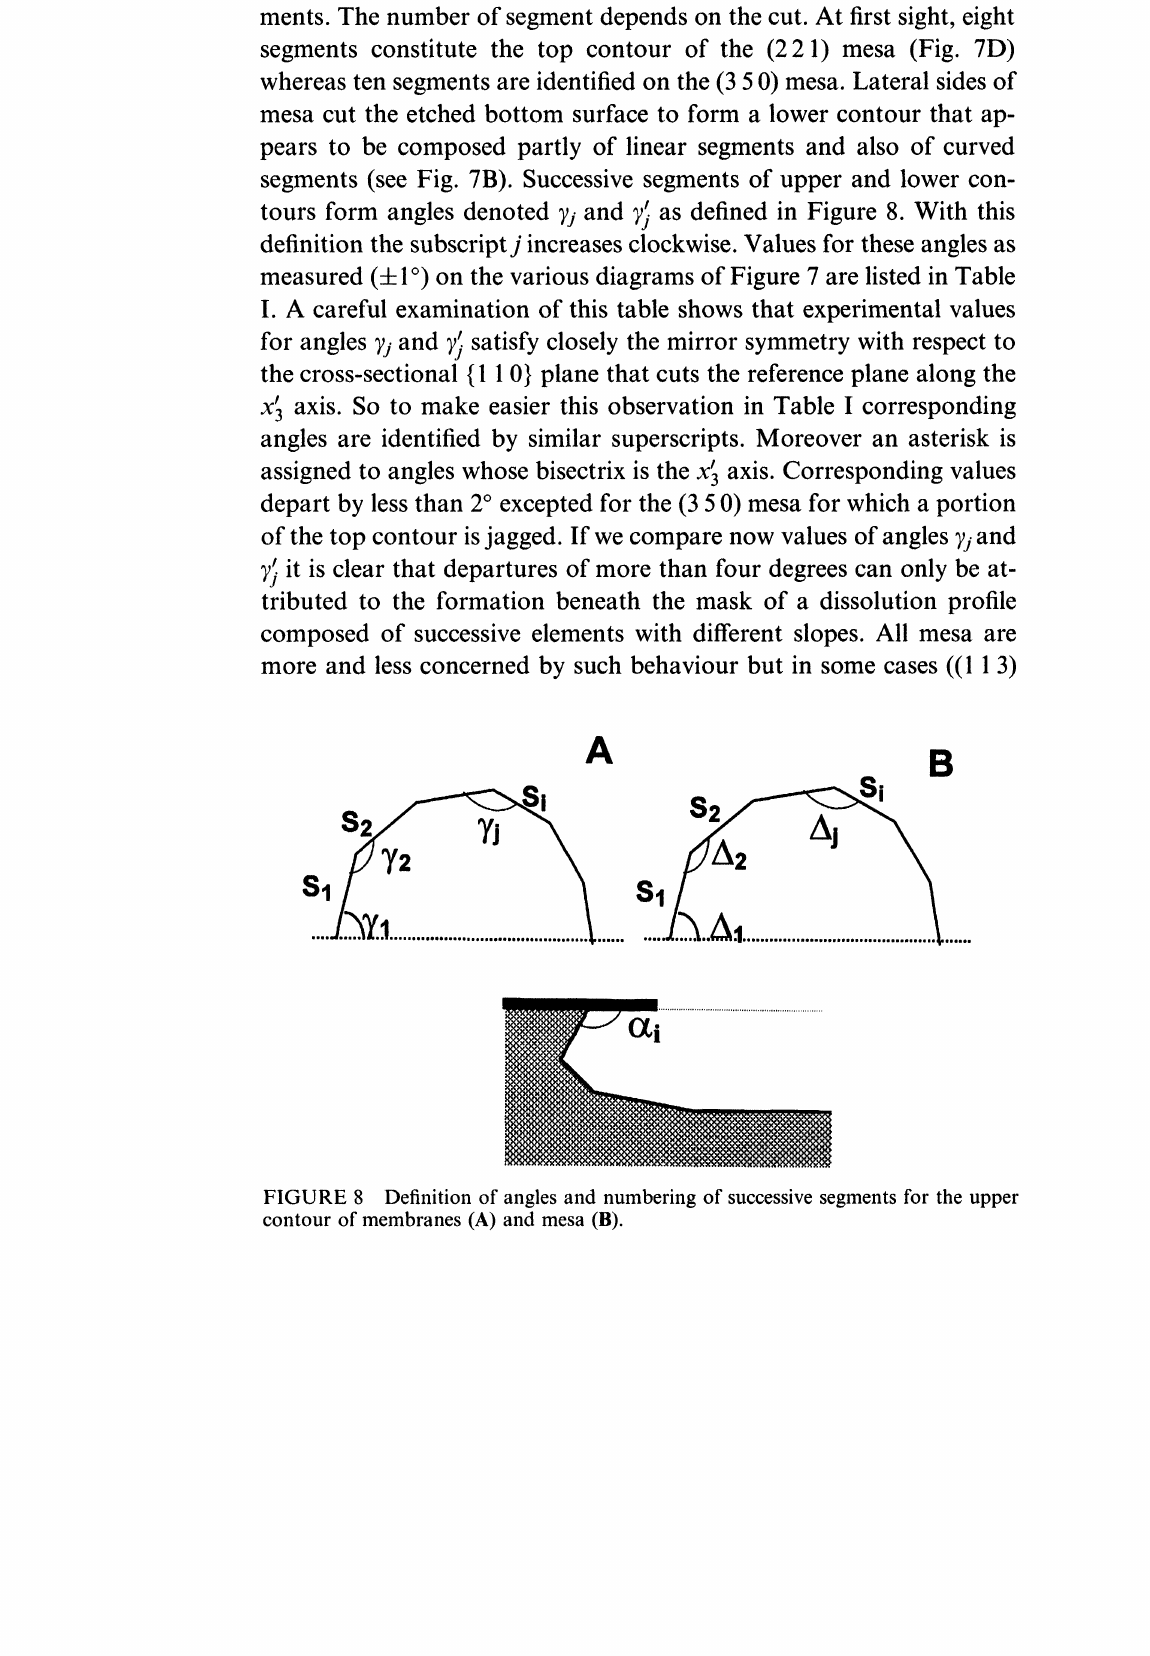
FIGURE 8 Definition of angles and numbering of successive segments for the upper contour of membranes (A) and mesa